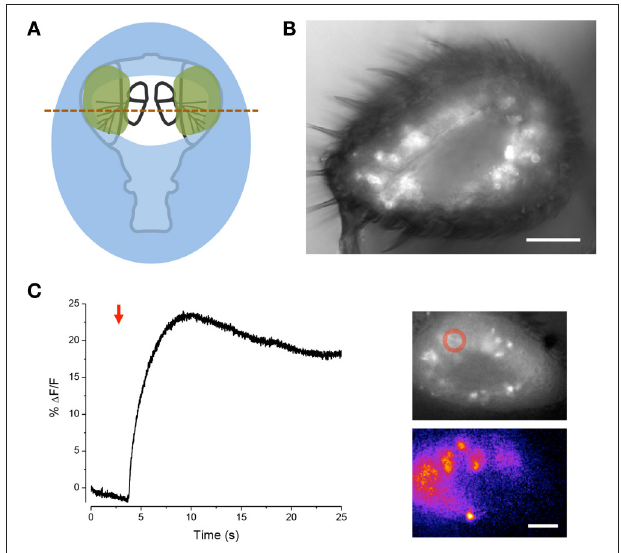
FIGURE 6 | Sectioning A3 and response of ORNs to odorant. (A) Schematic of the procedure. Place the cut head on a droplet of LCR (blue) and allow sinking so that the margins of the head, but not the arista, become covered. Light cure for 20s. Apply small droplets of LCR over the arista and margins of the antennae (green). Note, the frontal surface of A3 should not be covered so that the sensory sensilla are free. Add droplet of water over preparation and cure for 1 min. Wick off water with tissue. Add droplet of DS and cut through the A3s (red line). (B) Image of goggatomize A3 expressing GCaMP6. (C) Increase in intracellular calcium in ORNs expressing GCaMP6 to the application of iso-amyl acetate (arrow, a 5 µ l drop of a 0.67 mM solution was added to the ∼ 2ml bath). Upper inset, fluorescence prior to odorant application. Lower inset pseudo-color difference image. Scale bar 20 µ